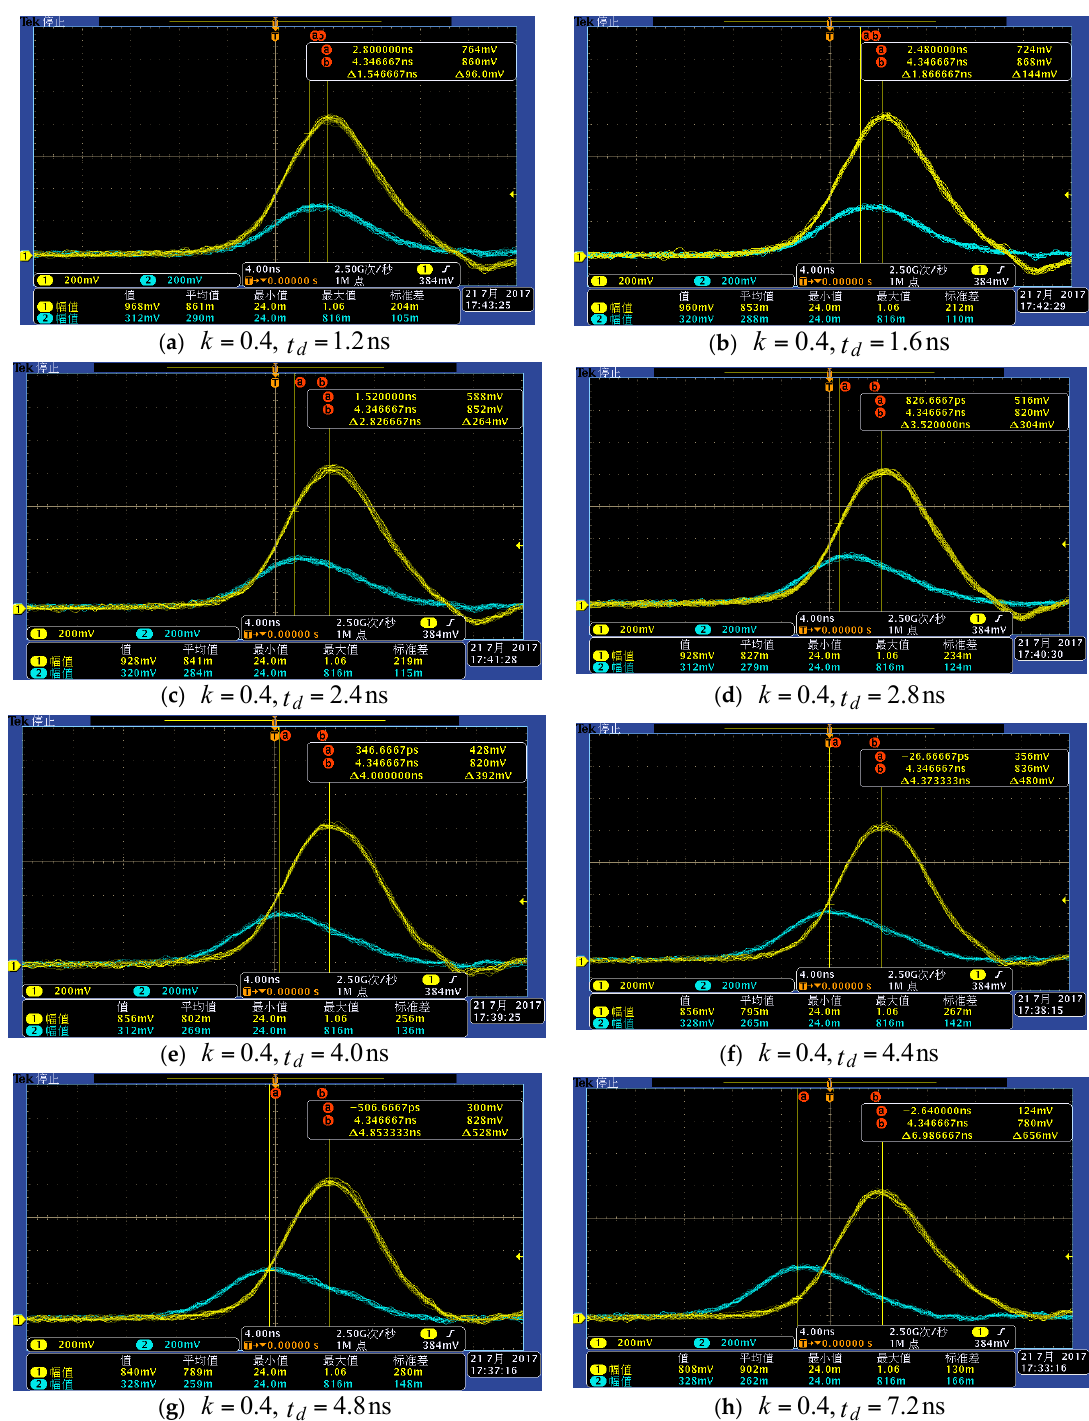
Figure 14. Sampled figures of the attenuated signal and delayed signal. Curve in yellow color represents the delayed signal and curve in cyan color represents the attenuated signal. The delayed signals were moved through adjusting the delay time for obtaining the various the moment of t T . All figures are sampled in the case of k = 0.4. ( a ) the sampled figure when t d = 1.2; ( b ) the sampled figure when t d = 1.6; ( c ) the sampled figure when t d = 2.4; ( d ) the sampled figure when t d = 2.8; ( e ) the sampled figure when t d = 4.0; ( f ) the sampled figure when t d = 4.4; ( g ) the sampled figure when t d = 4.8; ( h ) the sampled figure when t d =